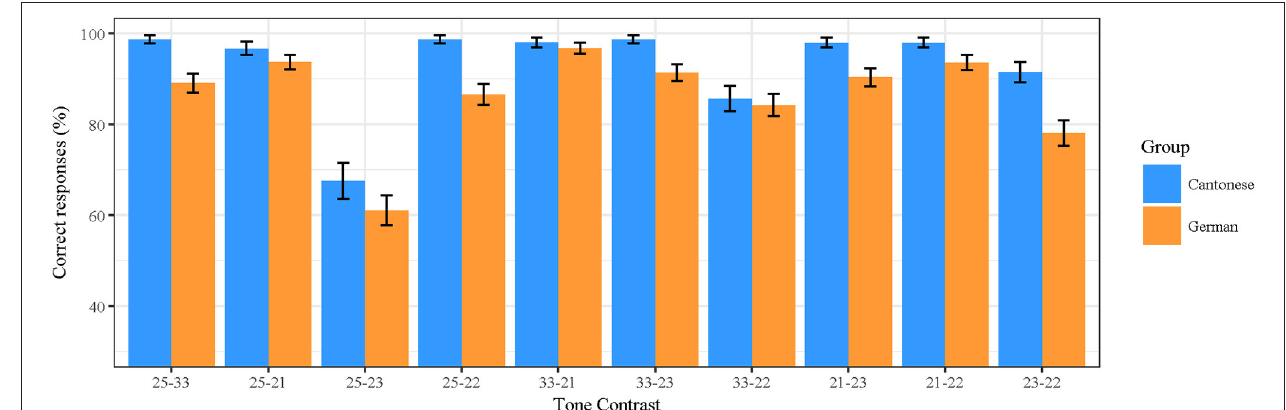
FIGURE 2 | Results from the AXB discrimination task, separated by group and tone contrast.